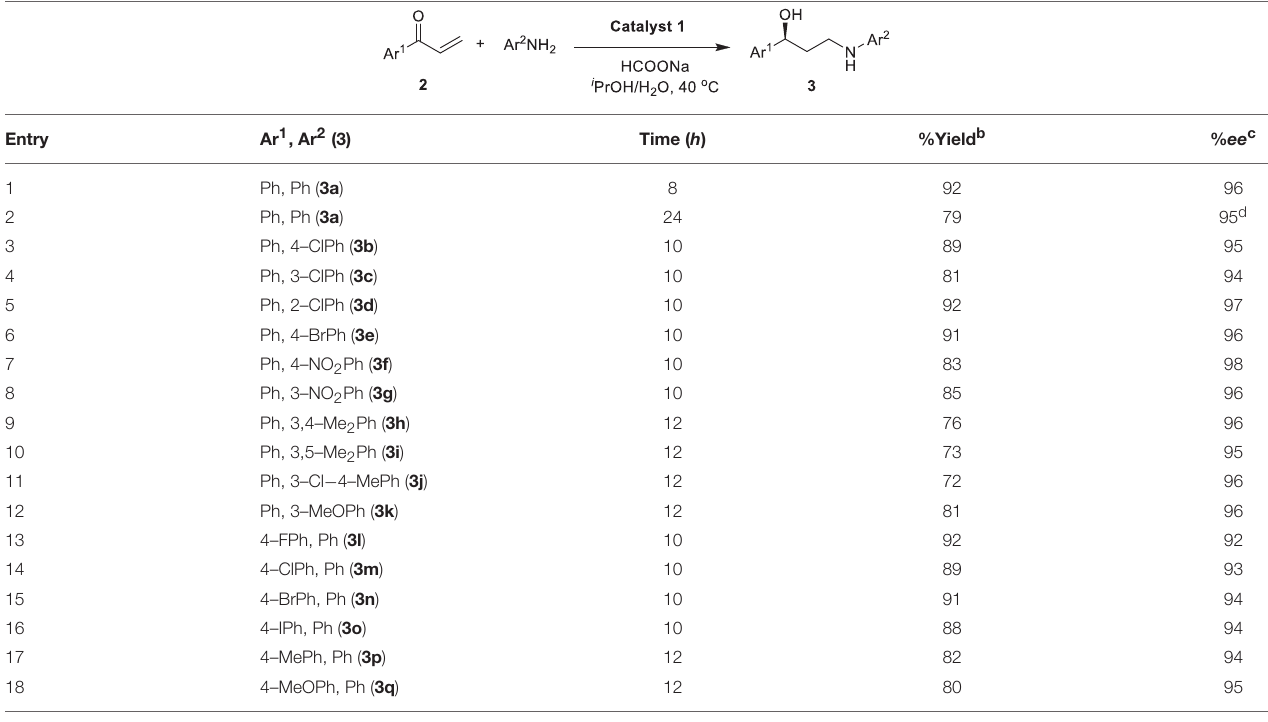
TABLE 1 | The aza–Michael addition/ATH one–pot enantioselective tandem reactions to prepare chiral γ -secondary amino alcohols a